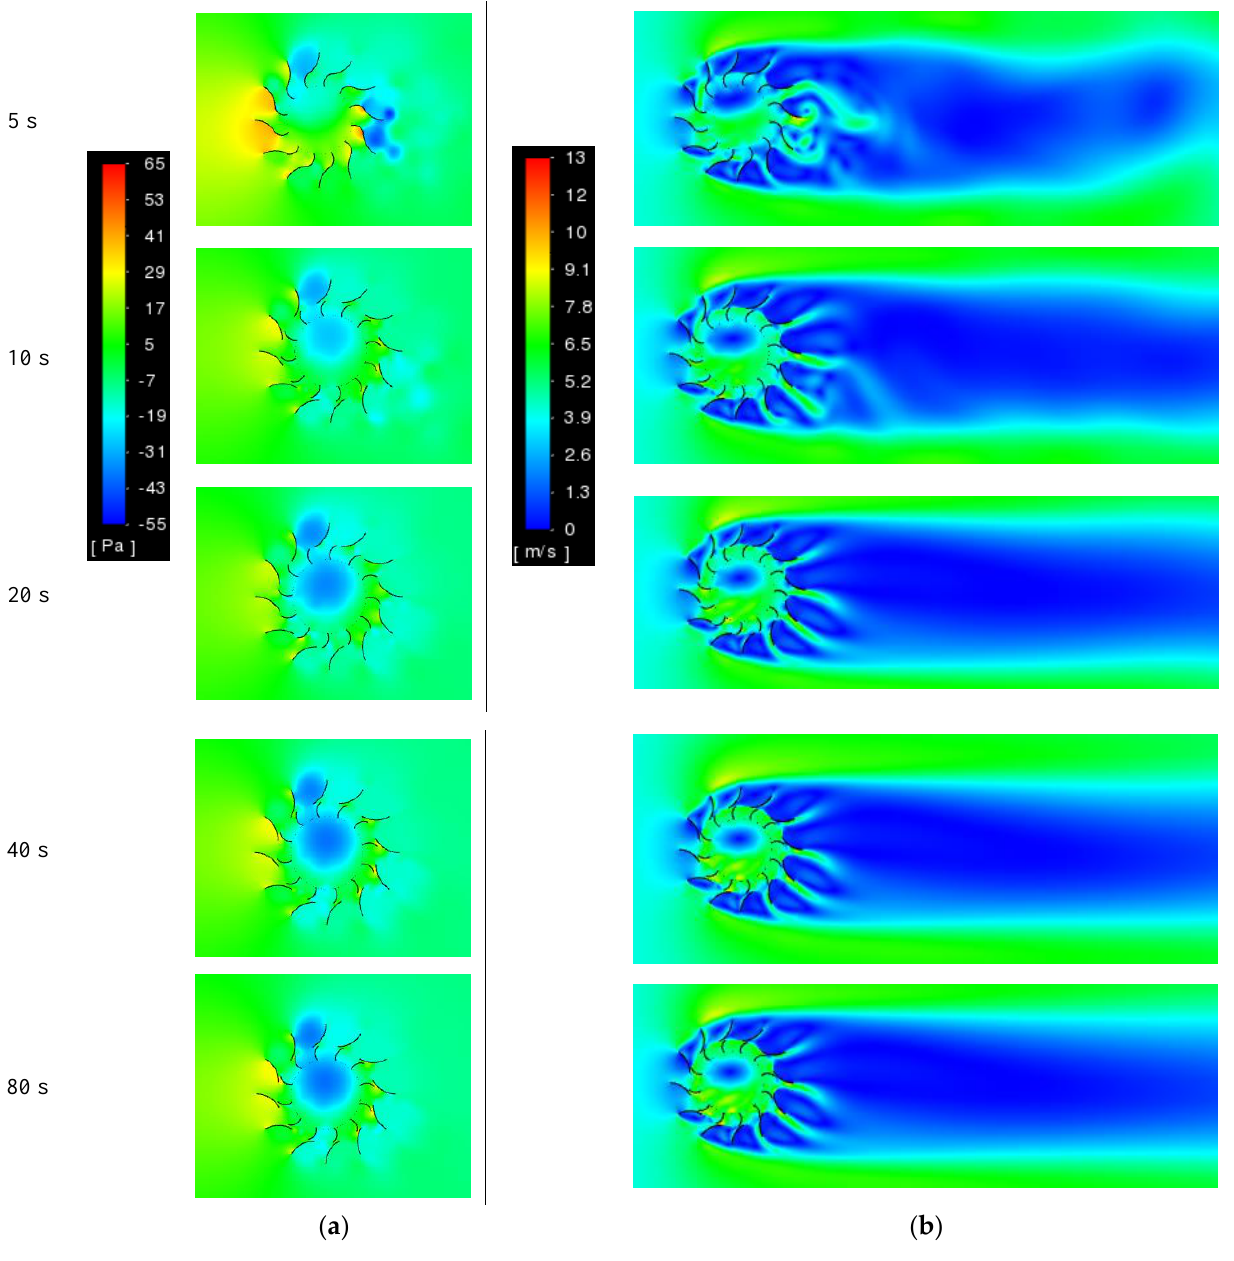
Figure 9. ( a ) Static gauge pressure and ( b ) flow velocity magnitude variations in the vicinity of the VAWT with stator. VAWT with